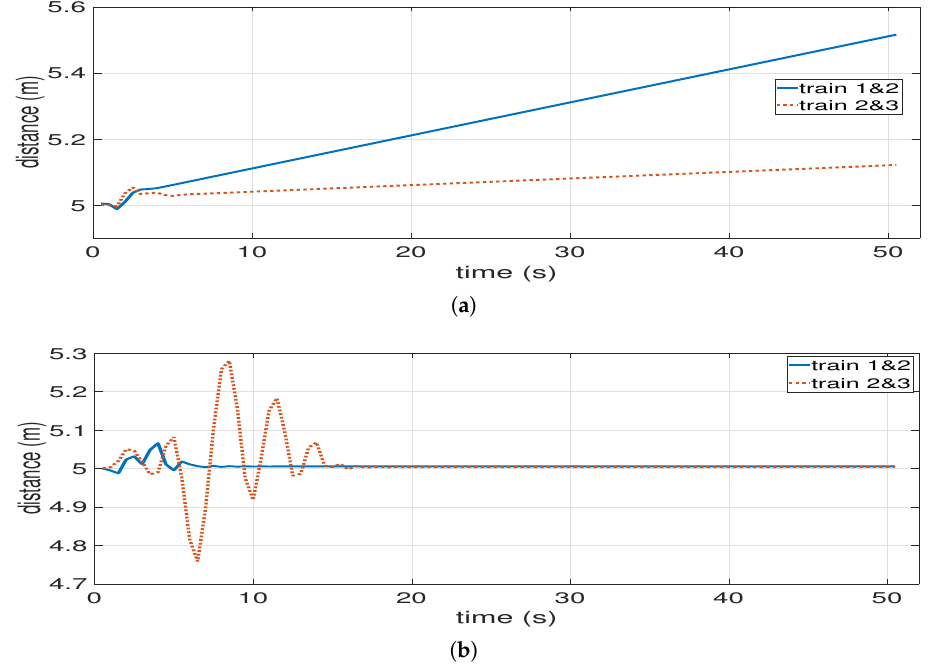
Figure 9. Comparison of distance between trains. ( a ): The distance between trains with MPC system. ( b ): The distance between trains with AMPCVS